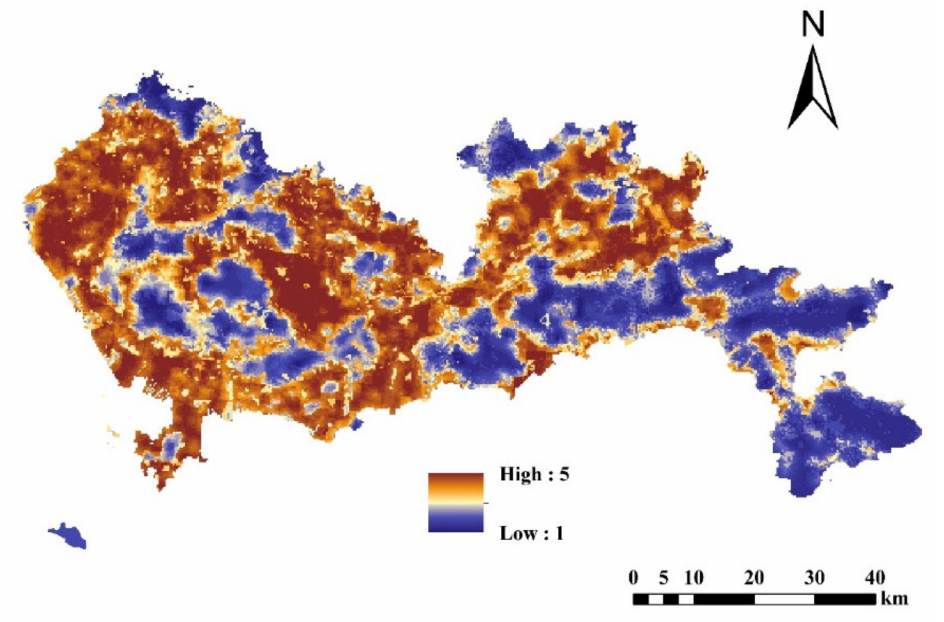
Figure 6. Resistance value distribution in the study area.